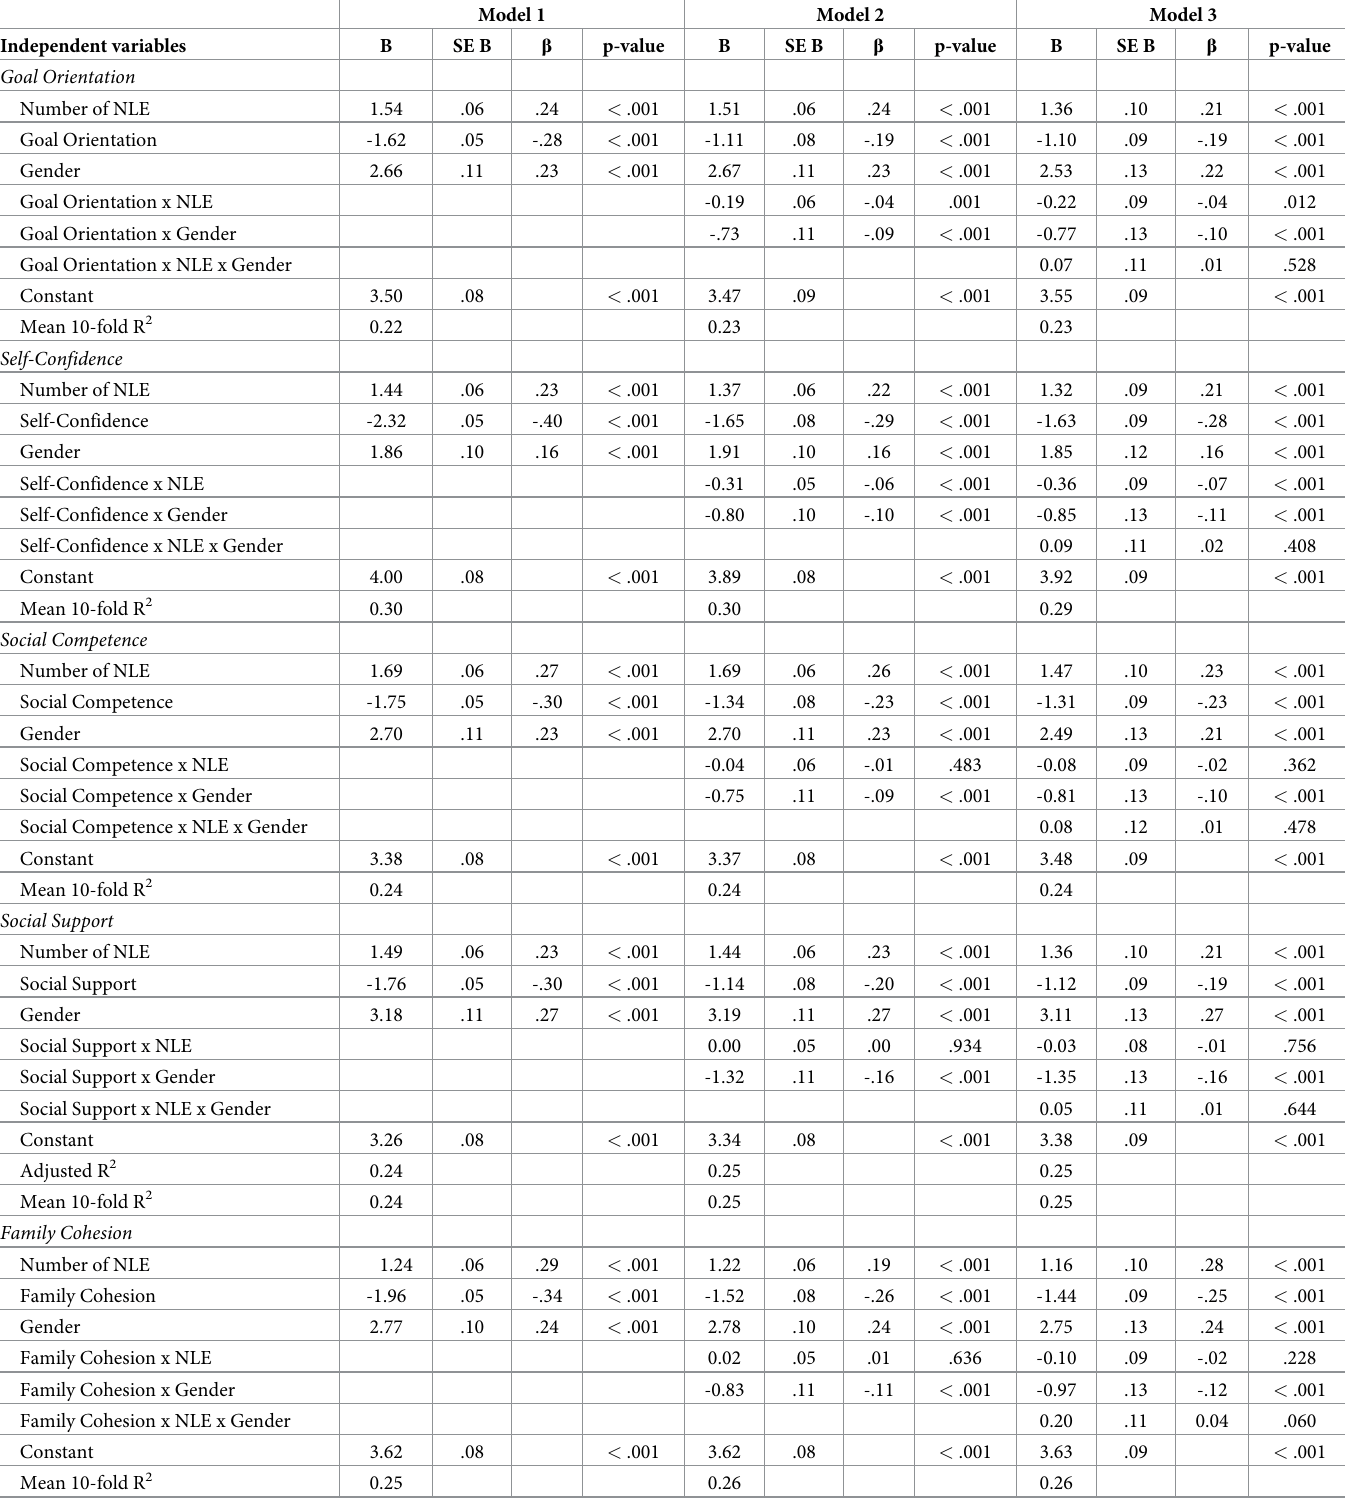
Table 3. Regression of negative life events and protective factors (in separate analyses) as predictors of symptoms of